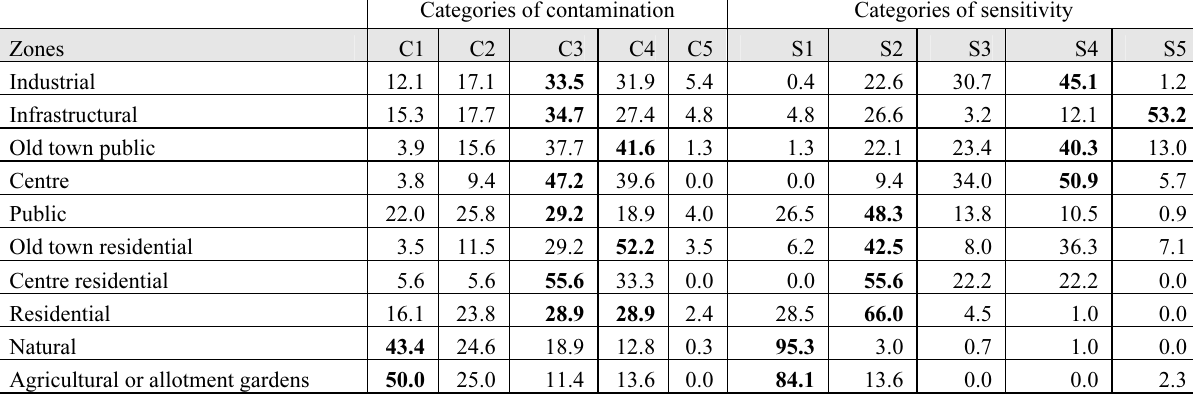
Explanation: the highest percentage of Zd for each category of S is in bold. Table 2. Distribution of percentage of categories of contamination and sensitivity to chemical pollution in types of functional